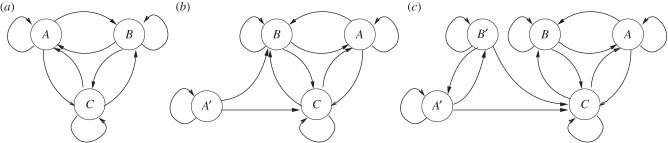
Differentiation graph for three cell types. Nodes represent cell type, arrows indicate that the cell type pointed to will be present in an adult that originated in a spore of the originating cell type. (a) Original differentiation graph. (b) Differentiation graph with epimutation in which A mutates to A′, and this epimutation is lost in the differentiation to B and C. (c) Differentiation graph in which A is mutated to A′. The epimutation is retained in differentiation to B, which leads to the creation of B′. The epimutation is lost in differentiation of A′ and B′ into C.